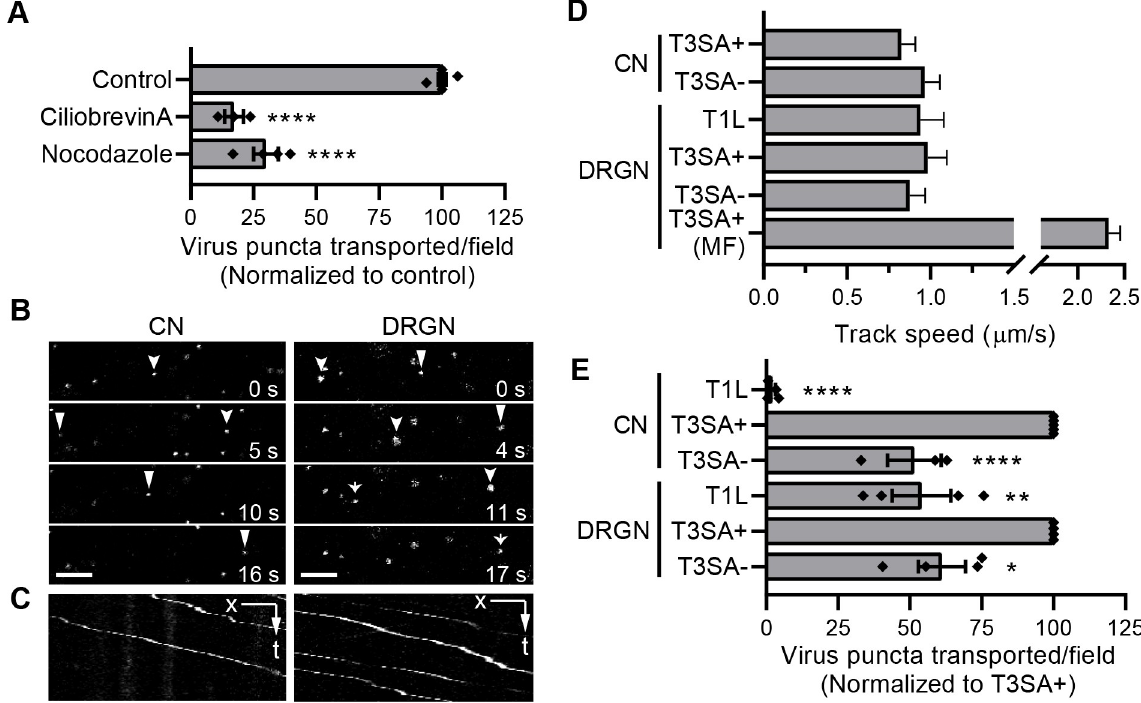
Fig 3. Reovirus undergoes microtubule-dependent fast axonal transport in neurons. (A) CNs were treated with the drugs shown, adsorbed with T3SA+ virions, and viral puncta transported per field-of-view were enumerated following treatment. Bars indicate mean values from at least two independent experiments, each with one to two samples, normalized to untreated control. Error bars indicate SEM. Individual data points are averages from 8 to 12 fields-of-view from each sample. Values that differ significantly from control by ANOVA and Dunnett’s test are indicated ( ���� , P < 0.0001). (B-E) CNs or DRGs were adsorbed with fluorescently-labeled T1L, T3SA+, or T3SA- virions for 30 min. The inoculum was removed, and the motion of virions was recorded using live-cell fluorescence imaging. (B) Time-lapse images of representative fields are shown for T3SA+ with positions of individual puncta tracked over time with discrete arrows or arrowheads. (C) Kymographs corresponding to B show the positions (x) of individual puncta along an axon over time (t). Scale bars, 5 μ m. (D) Track speed was calculated for the reovirus strains shown as the overall distance traveled by each fluorescent reovirus puncta during the tracked interval ( n > 300 tracks). MF refers to neurons cultured in microfluidic devices. Bars indicate medians, and error bars indicate 95% confidence intervals. (E) Fluorescent puncta transported for distances greater than 5 μ m in each 82 x 82 μ m field-of-view during 1 min of live-cell imaging were enumerated. Bars indicate means normalized to T3SA+, and error bars indicate SEM. Individual data points are averages from 8 to 12 fields-of-view for each sample. Values that differ significantly from T3SA+ by ANOVA and Dunnett’s test are indicated ( � , P < 0.05; �� , P < 0.01; ���� , P <